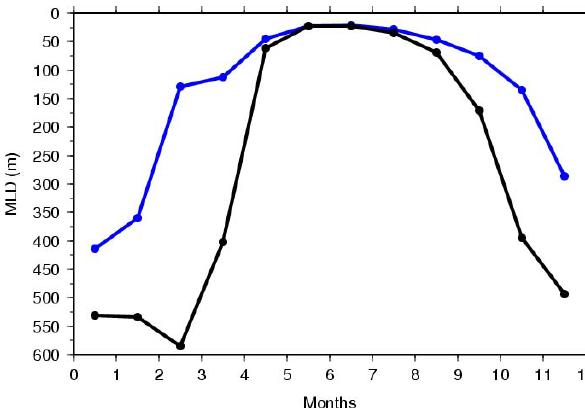
Fig. A2. Seasonal climatology of mixed layer depth (MLD) from de Boyer Montégut et al. (2004) (blue) and from GPOMZ at the ECO1D-2.0 site. There is good agreement from May to September, but GPOMZ MLD is much deeper in winter and late